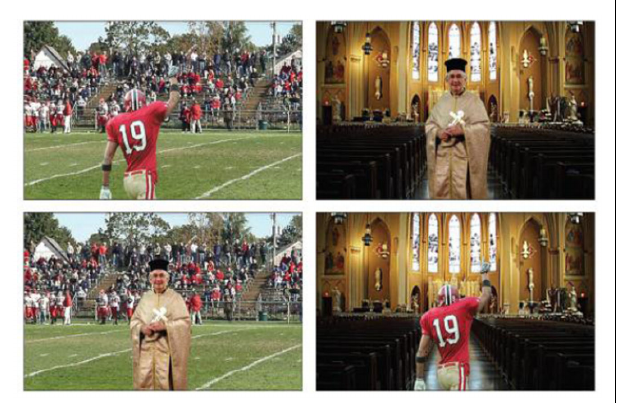
FIGURE 1 | Examples of consistent scenes (top row) and inconsistent scenes (bottom row). In all cases, the central figure or object was photoshopped onto the background picture. Participants viewed only one of the versions of a given picture, and reported either the central object, the background setting, or both. From Davenport and Potter